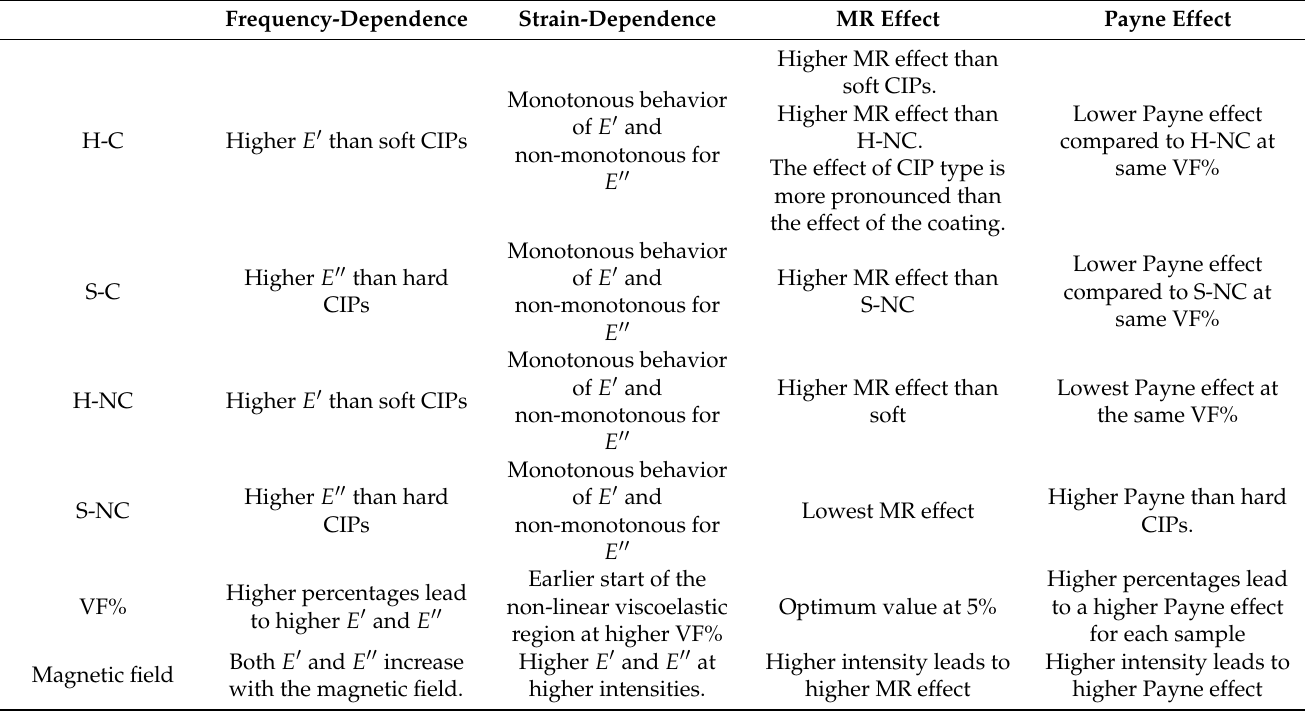
Table 5. Results and analysis